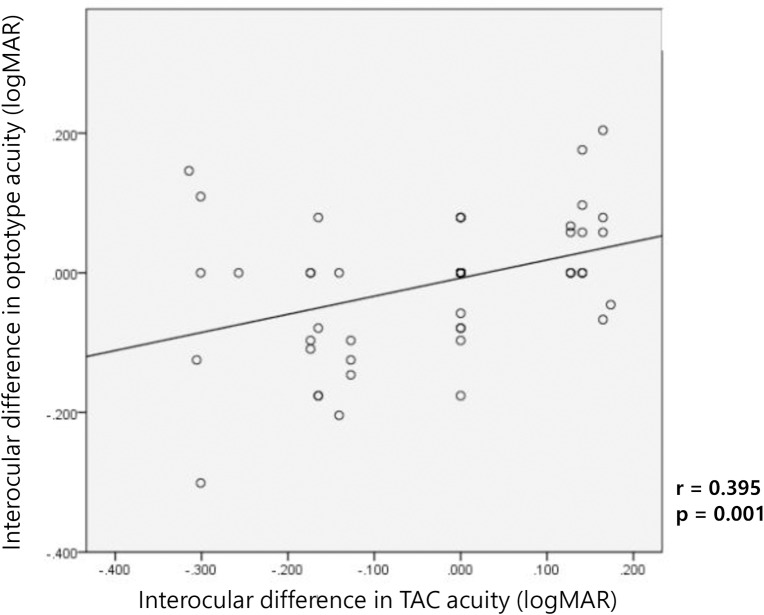
Significant correlation between interocular differences in visual acuity in the TAC and optotype tests.